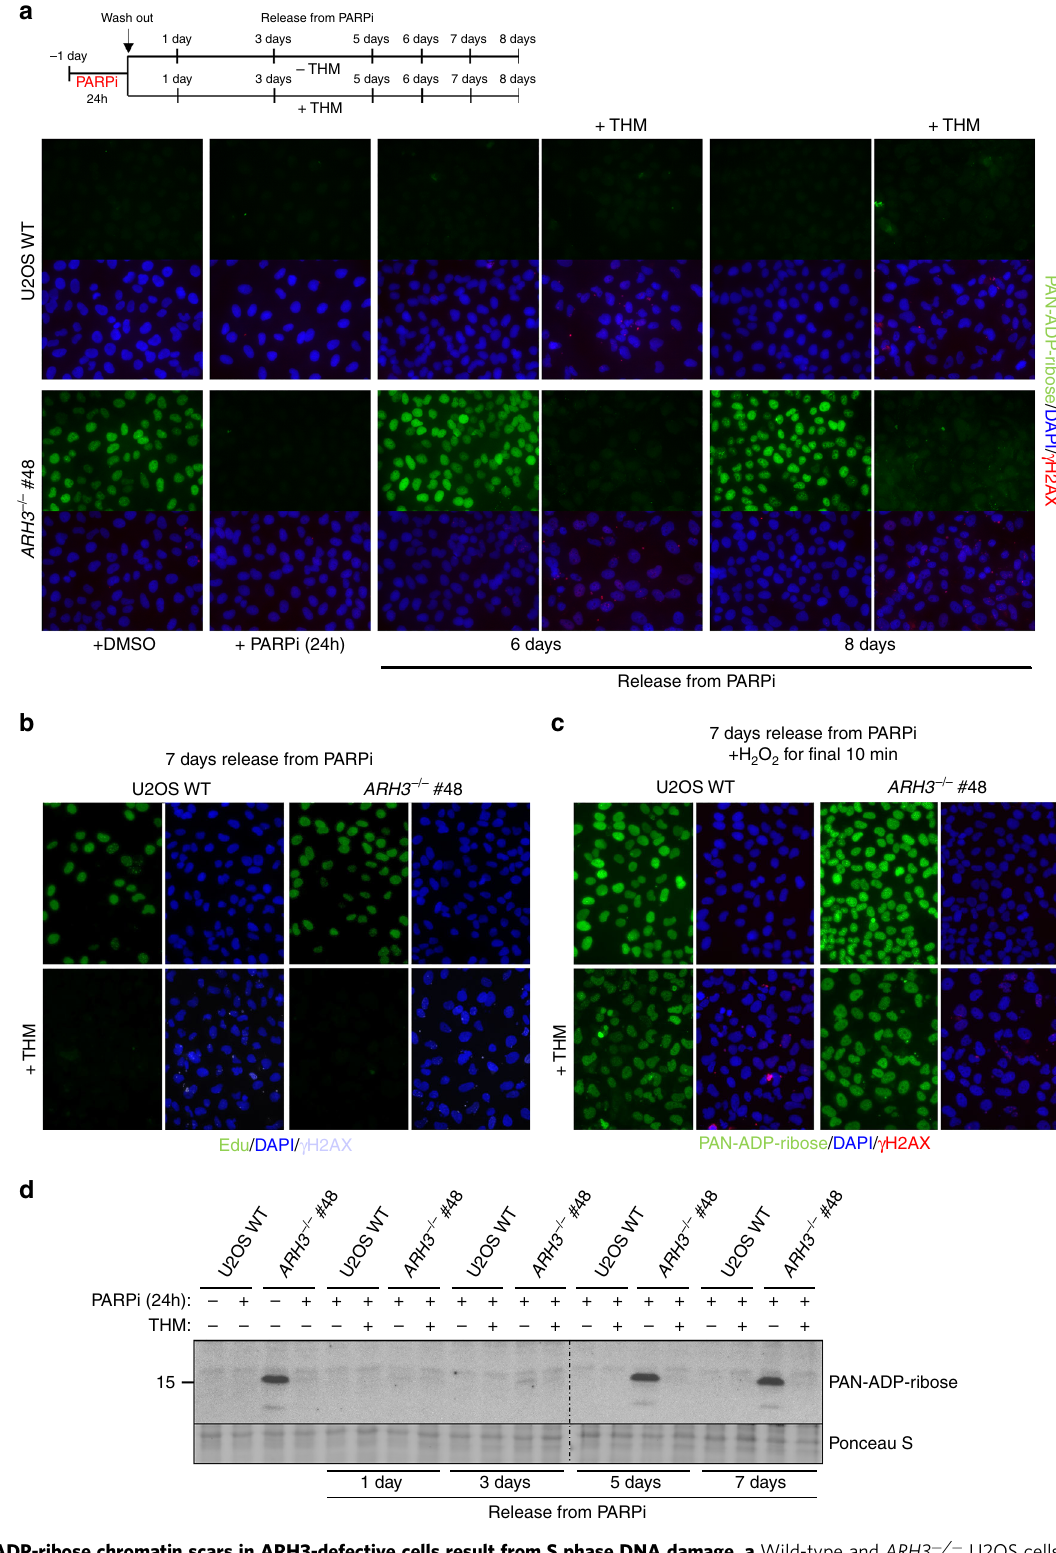
Fig. 5 The ADP-ribose chromatin scars in ARH3-defective cells result from S phase DNA damage. a Wild-type and ARH3 − / − U2OS cells were treated with DMSO vehicle or 10 μ M PARPi for 24 h, washed, and then incubated in PARPi-free medium with or without 2.5 mM thymidine (THM) for the indicated time periods. ADP-ribose levels in chromatin were then measured by indirect immuno fl uorescence in detergent pre-extracted cells with anti- PAN-ADP-ribose binding reagent. b Cells treated as above were pulse-labeled at day 7 after release from PARP inhibitor with 10 μ M EdU for the last 20 min prior to harvesting, to con fi rm that thymidine-induced cell-cycle arrest was successful. c Cells treated as in a were incubated on day 7 with 150 μ M H 2 O 2 for 10 min and ADP-ribose levels then measured, to con fi rm that PARP can be activated in thymidine-arrested cells. γ H2AX in a , b , and c was used as a marker of replication stress in thymidine treated cells. Representative images for a , b , and c are shown. Scale bar, 20 μ M. d Wild-type and ARH3 − / − U2OS cells were treated as in a and ADP-ribosylated histones detected by western blotting, using anti-PAN-ADP-ribose binding